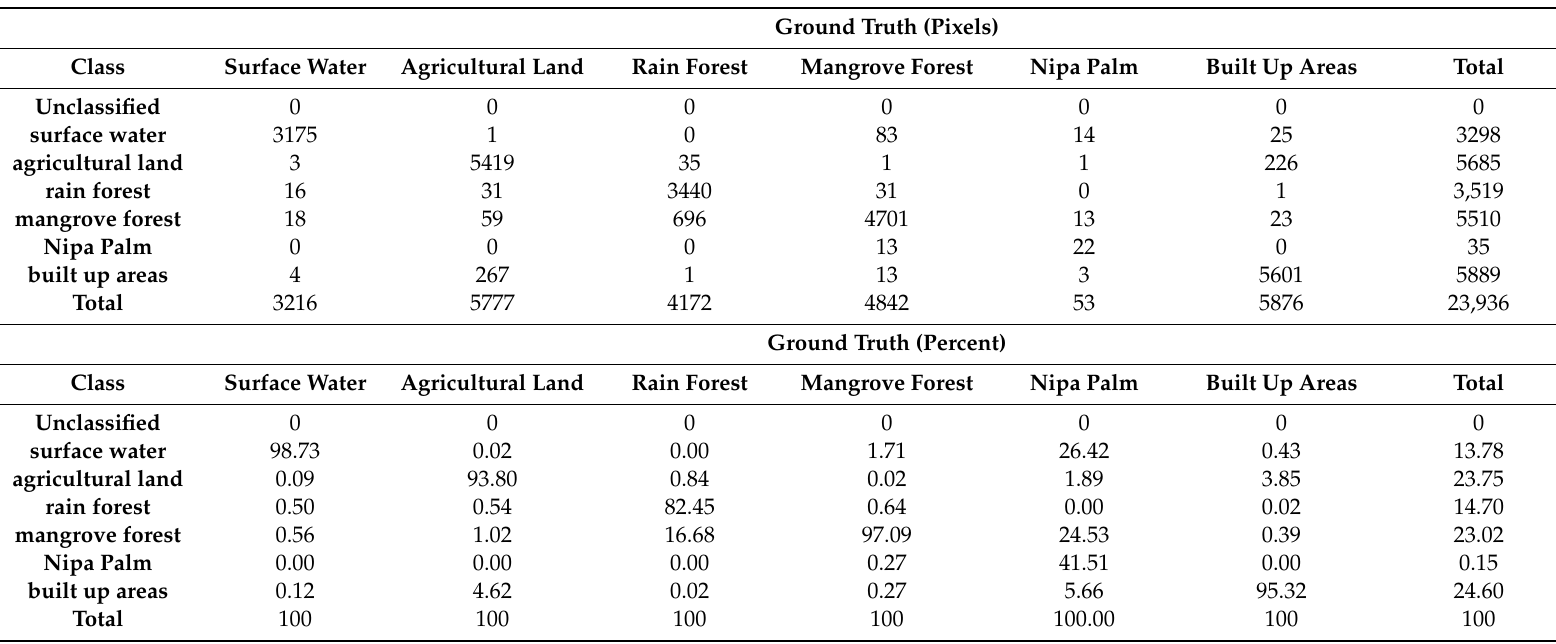
Table 5. Confusion Matrix of the 2007 SVM Radial Basis Function kernel Land Cover Classification of the Niger